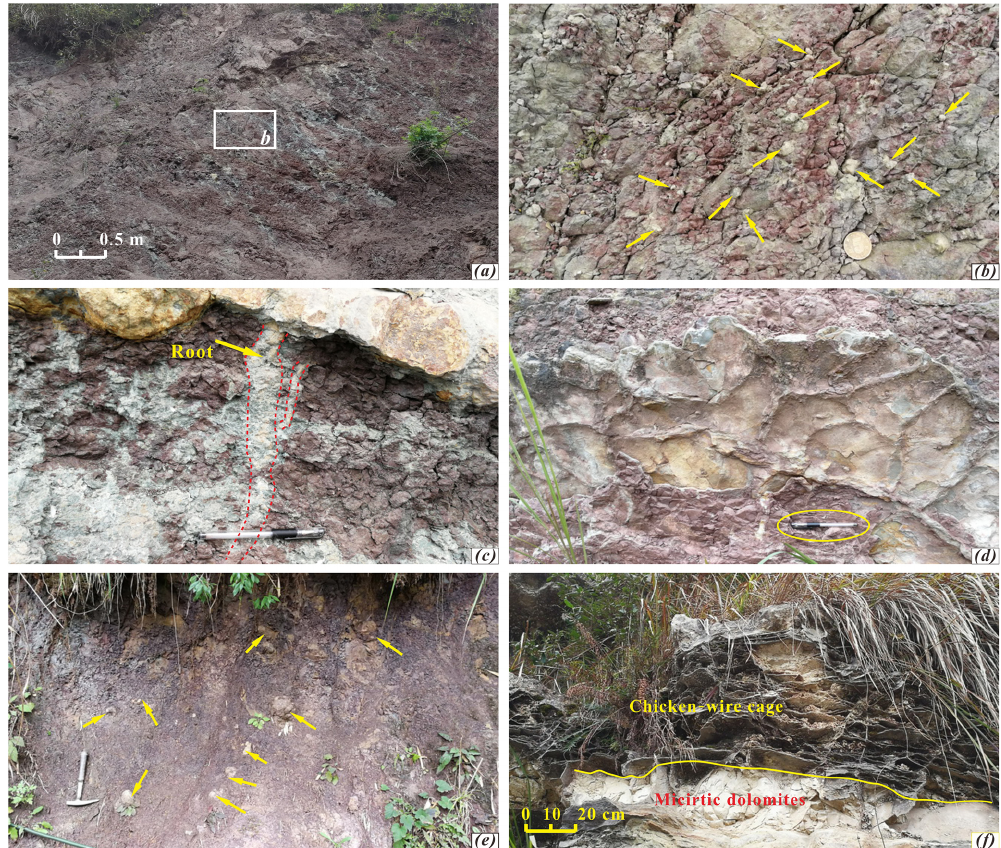
Figure 3. Field photographs of climate-sensitive sediments from the Lower Jurassic Ziliujing Fm in the GSB. (a) Reddish purple calcisol with strong leaching structure from lower Bed H8 of the upper Ma’anshan Member at Tanba, Hechuan. (b) Reddish purple calcisol showing the density and size of calcretes. The horizon and location are the same as (a) . Arrows point to calcretes. The coin is 2.0cm in diameter. (c) Reddish purple calcisol with strong leaching structure and rhizoliths from Bed H13 of the top Ma’anshan Member at Maliuping, Hechuna. The pen is 15cm long. (d) Mudcracks from lower Bed H8 of the upper Ma’anshan Member at Maliuping, Hechuan. The pen is 15cm long. (e) Brownish red calcisol with big calcretes (calcareous concretions). Arrows point to big calcretes. Calcisol horizon J1z-10-01 from Bed B10 of the Ma’anshan Member at Shaping, Ya’an. The hammer is 34cm long. (f) Chicken-wire cage structure from Bed H12 of the Da’anzhai Member at Maliuping,